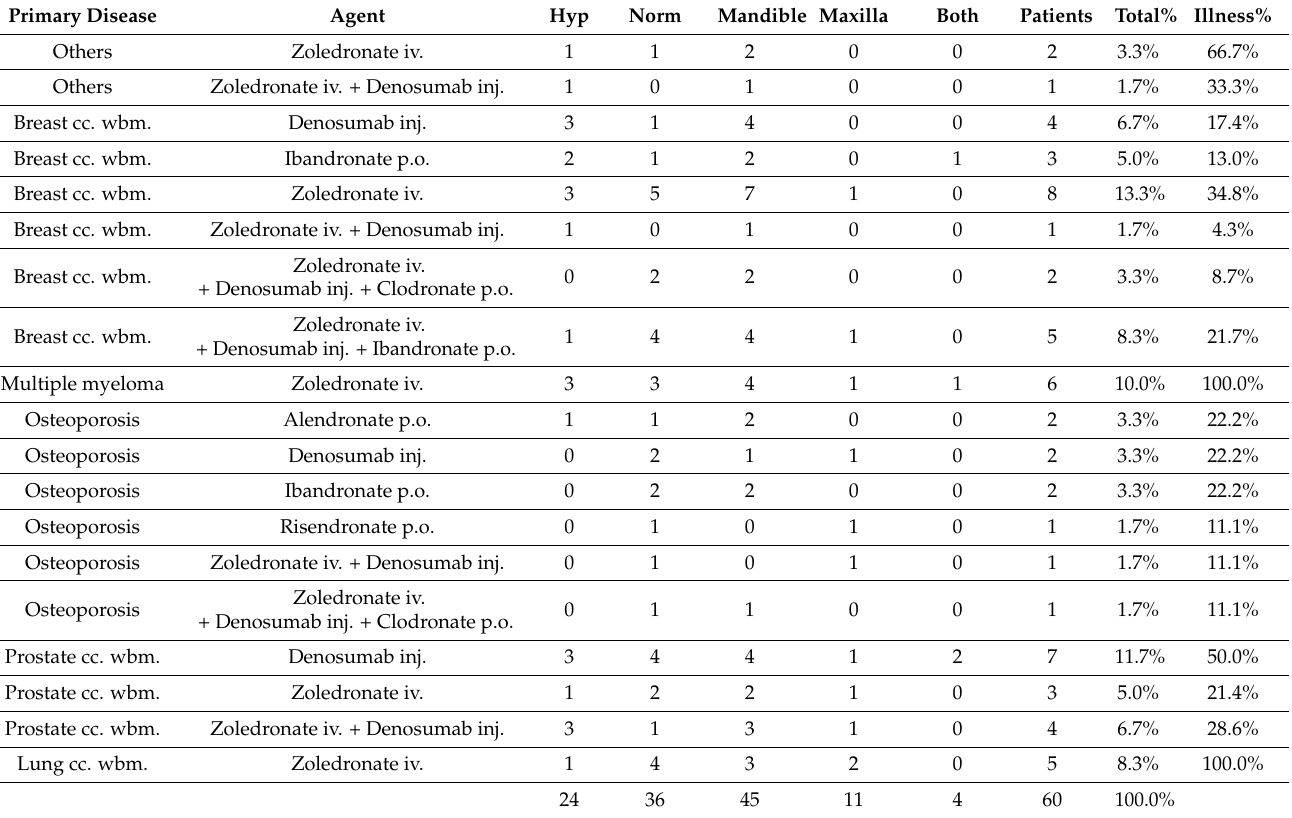
Table 3. Different parameters (primary disease and its associated medications, glucose balance, and location of necrosis in patients with